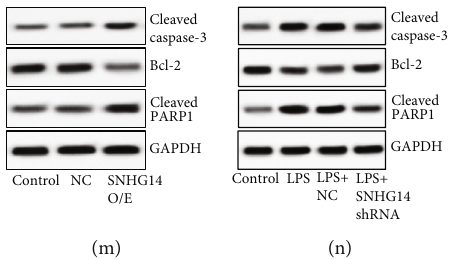
Figure 2: SNHG14 is involved in the oxidative stress, in fl ammation, and apoptosis of LPS-induced HK-2 cells. (a – n) HK-2 cells were transfected with SNHG14 overexpression plasmids, and LPS-induced HK-2 cells were transfected with SNHG14 shRNAs; SNHG14 expressions were detected with qRT-PCR (a, b); oxidative stress was assessed by detecting MDA levels (c, d) and relative ROS (e, f); in fl ammatory cytokines including TNF- α , IL-1 β , and IL-6 were measured at the transcriptional level through qRT-PCR (g, h) and in a cell supernatant using ELISA assays (i, j); cell apoptosis was analyzed using fl ow cytometry (k, l) and by detecting apoptosis-related biomarkers using western blot. Data were shown as mean ± SD , ∗ P < 0 : 05